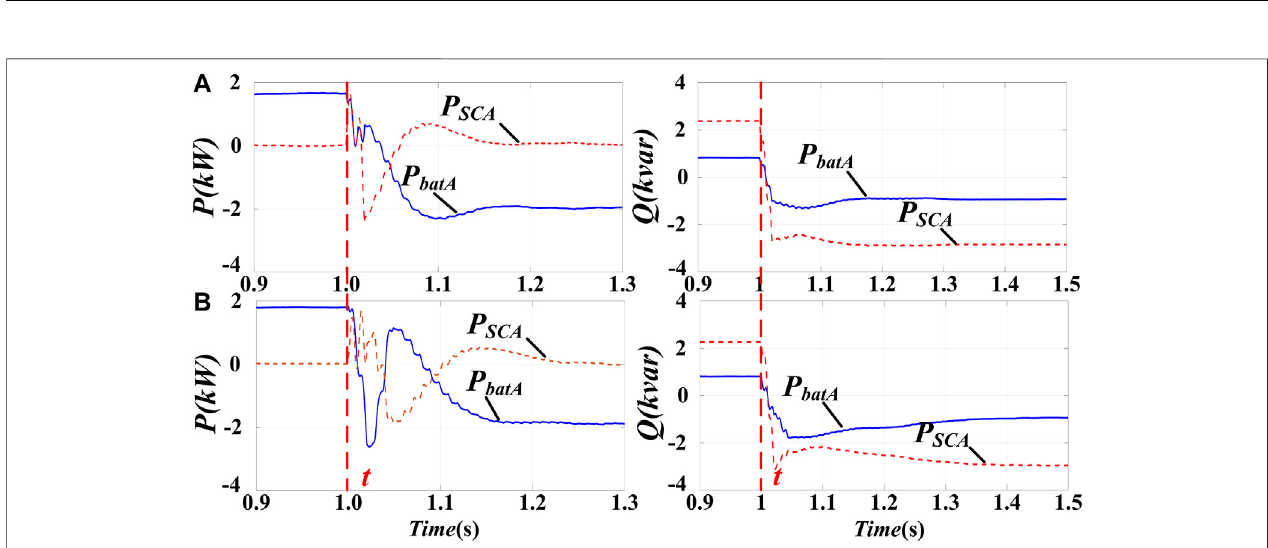
FIGURE 11 | Comparison between the proposed hierarchical power control and the conventional individual phase control; (A) Power waveforms using the proposed control strategy; (B) Power waveforms using the conventional method.